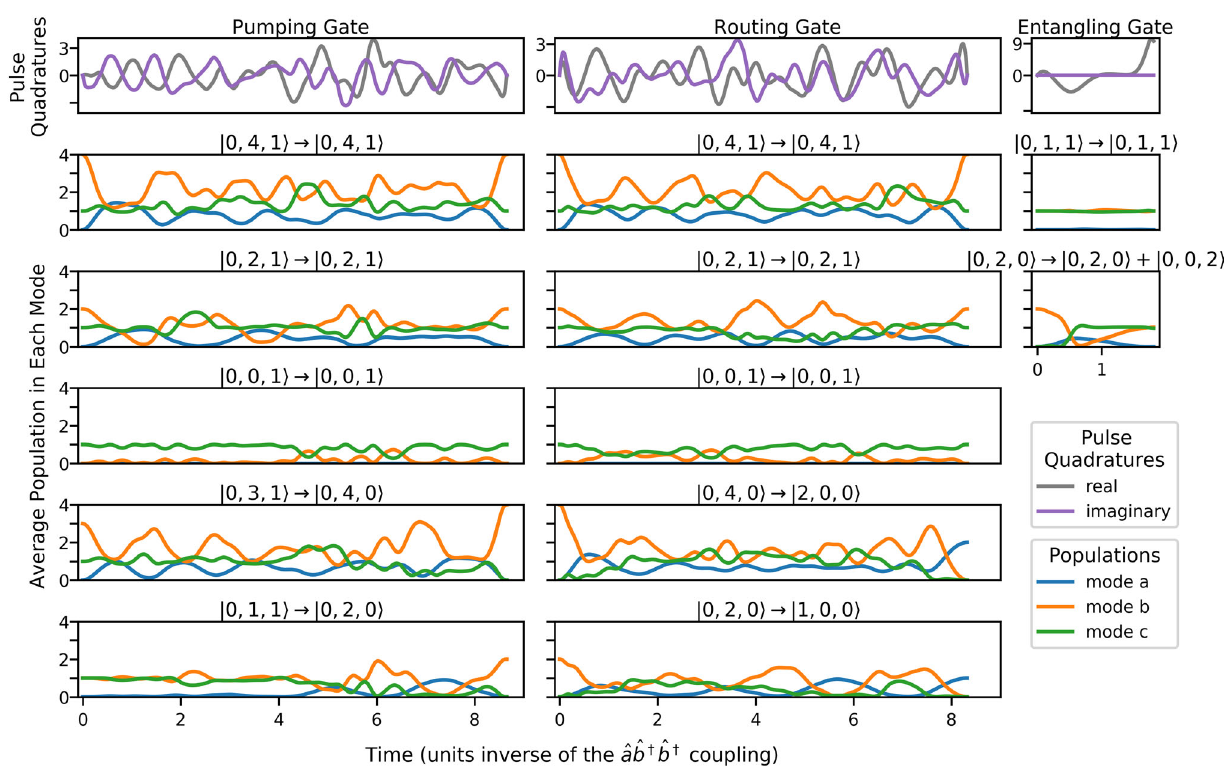
Fig. 2 The control pulses implementing the three gates that are used to build our error correction circuit. The top row shows the real and imaginary parts of the control pulses for each gate. The following rows show how the populations of the modes evolve under each gate for a given initial state. The optimizer produces pulses p ( t ) such that each of the desired transformations leads to constructive interference at the exact same time. Shorter pulses are possible, at the expense of higher power and bandwidth requirements 39 , up to a point at which the pulse is too short to perform even a single complete oscillation in a subspace de fi ned by an integer value of 2 n a + n b + n c